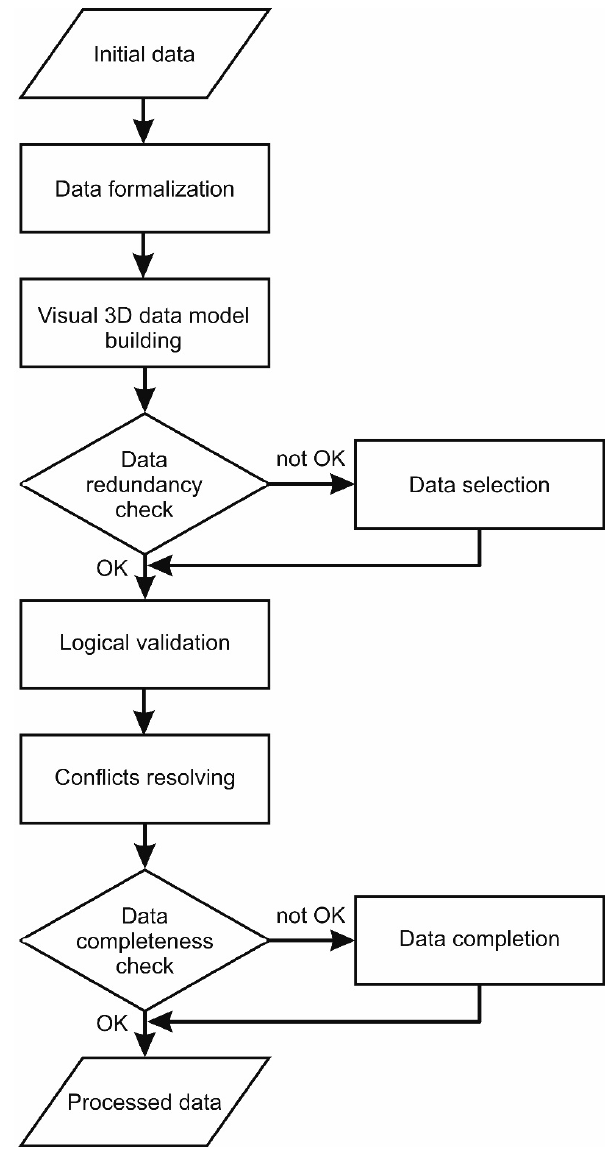
Figure 1. The scheme of initial data validation and completion algorithm.